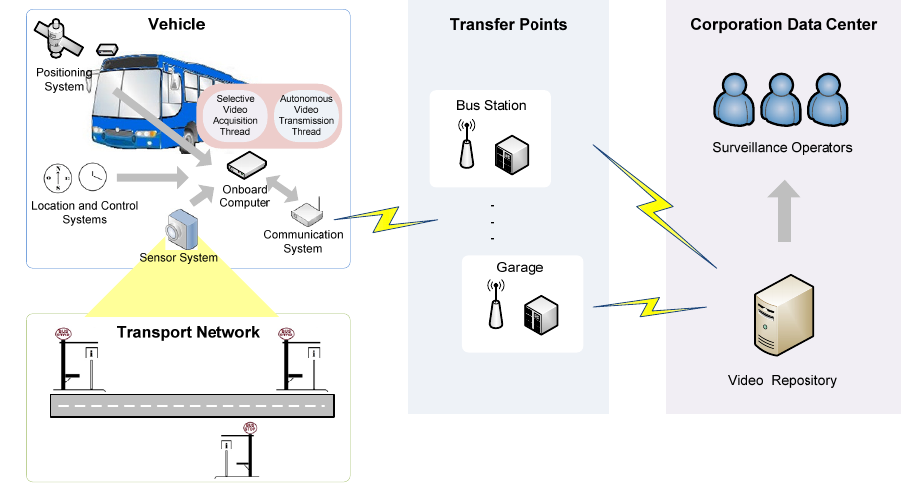
Figure 11. Surveillance system operation and elements.